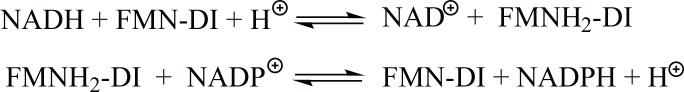
Proposed mechanism of FMN-DI catalyzing the hydride transfer between NAD(H) and NADP(H).